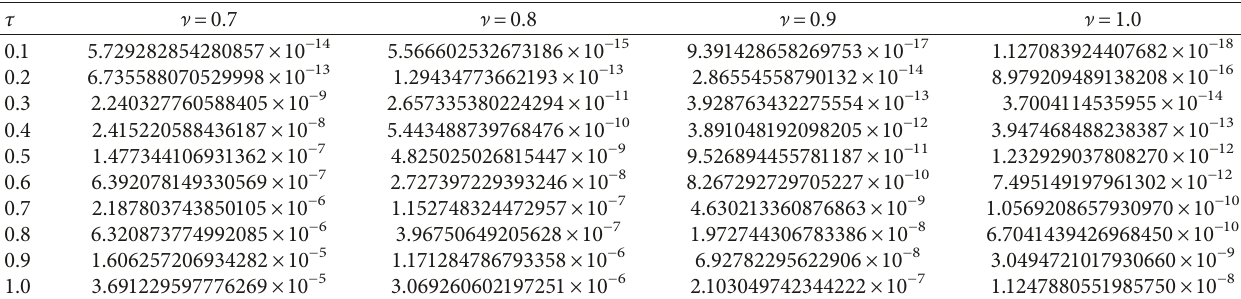
Table 6: The recurrence error of the 5th approximate solution of the imaginary part in Example